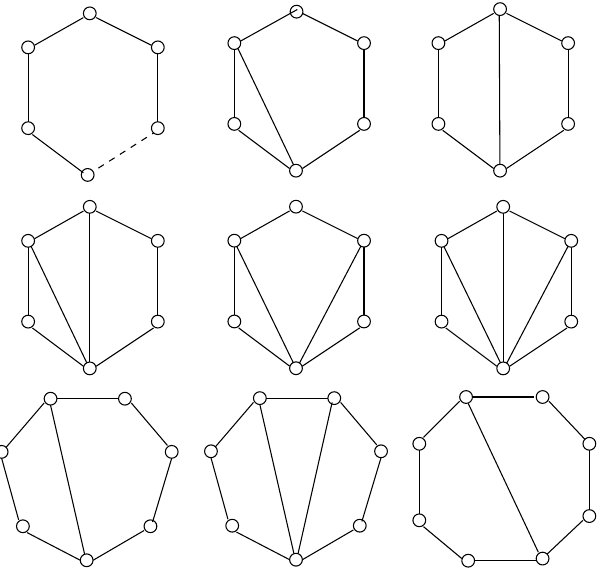
Figure 5. The minimal forbidden subgraphs of any graph with stretch number less than 2. Dashed lines represent paths of length at least